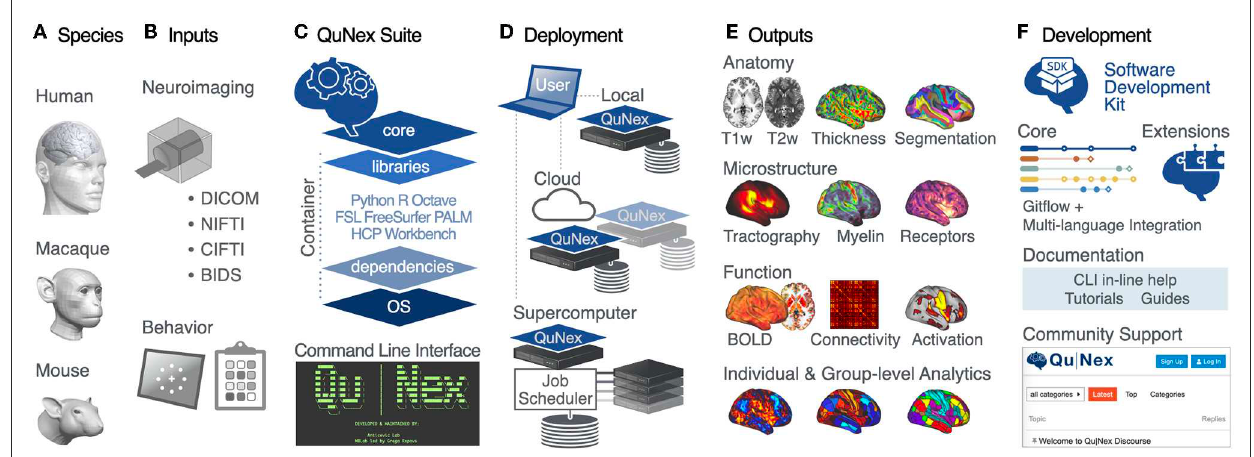
FIGURE1 QuNex provides an integrated, versatile, and flexible neuroimaging platform. (A) QuNex supports processing of input data from multiple species, including human, macaque, and mouse. (B) Additionally, data can be onboarded from a variety of popular formats, including neuroimaging data in DICOM, PAR/REC, NIfTI formats, a full BIDS dataset, or behavioral data from task performance or symptom assessments. (C) The QuNex platform is available as a container for ease of distribution, portability, and execution. The QuNex container can be accessed via the command line and contains all the necessary packages, libraries, and dependencies needed for running processing and analytic functions. (D) QuNex is designed to be easily scalable to accommodate a variety of datasets and job sizes. From a user access point (i.e., the user’s local machine), QuNex can be deployed locally, on cloud servers, or via job schedulers in supercomputer environments. (E) QuNex outputs multi-modal features at the single subject and group levels. Supported features that can be extracted from individual subjects include structural features from T1w, T2w, and dMRI (such as myelin, cortical thickness, sulcal depth, and curvature) and functional features from BOLD imaging (such as functional connectivity matrices). Additional modalities, e.g., receptor occupancy from PET (positron emission tomography), are also being developed (see Section Discussion). Features can be extracted at the dense, parcel, or network levels. (F) Importantly, QuNex also provides a comprehensive set of tools for community contribution, engagement, and support. A Software Development Kit (SDK) and GitFlow-powered DevOps framework is provided for community-developed extensions. A forum (https://forum.qunex.yale.edu) is available for users to engage with the QuNex developer team to ask questions, report bugs, and/or provide